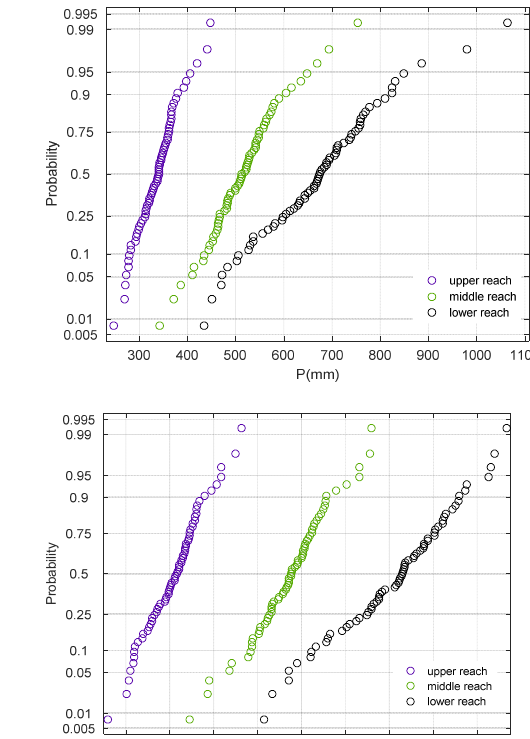
Figure 5. Probability plot of sc − PDSI, P, ET 0 , and AET in YRB on the yearly scale from 1951 to 2017.